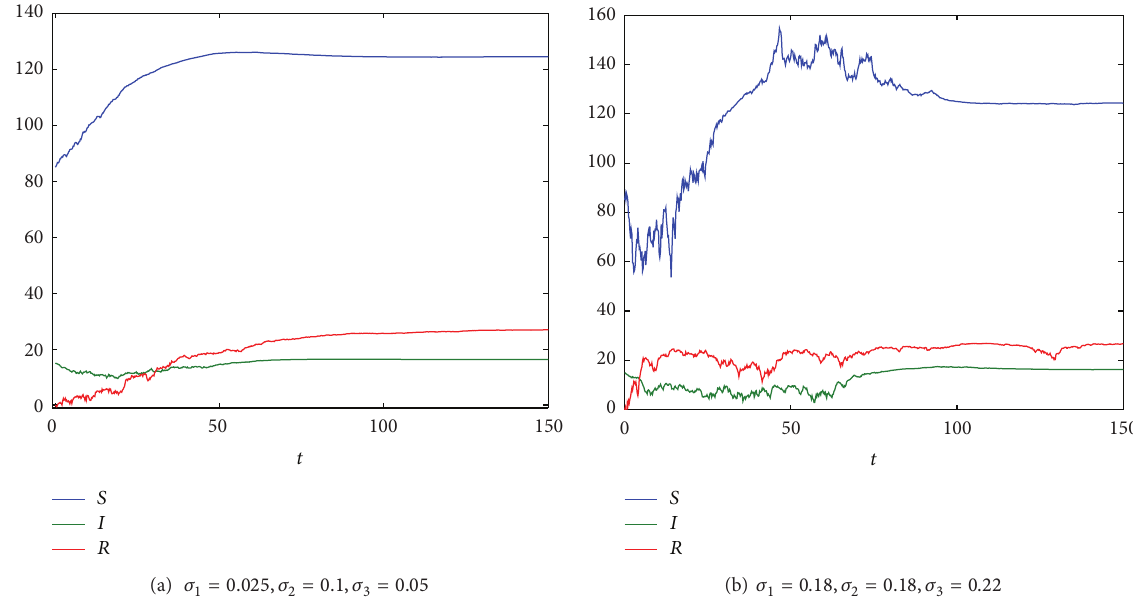
Figure 2: The asymptotic behavior of the solutions to the stochastic model (47) around the endemic equilibrium 𝐸 ∗ with initial values 𝑆(0) = 85 , 𝐼(0) = 15 , and 𝑅(0) = 0 . The parameters are taken as (20).